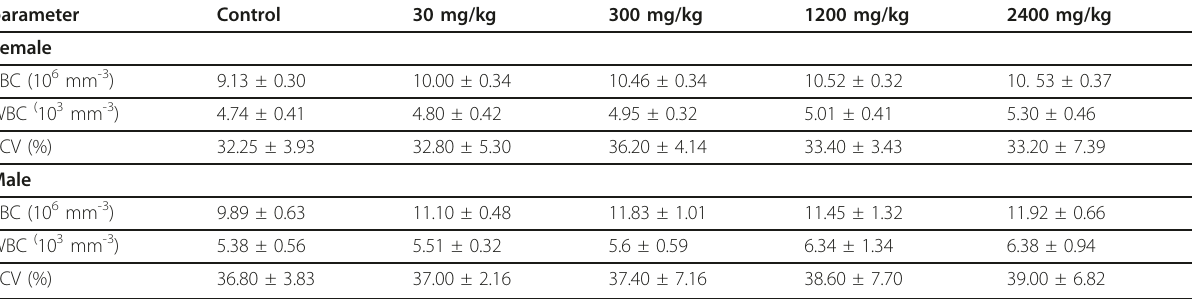
Table 3 Haematological parameters of rats in sub-acute toxicity of the ethyl acetate extract from Crassocephalum bauchiense parameter